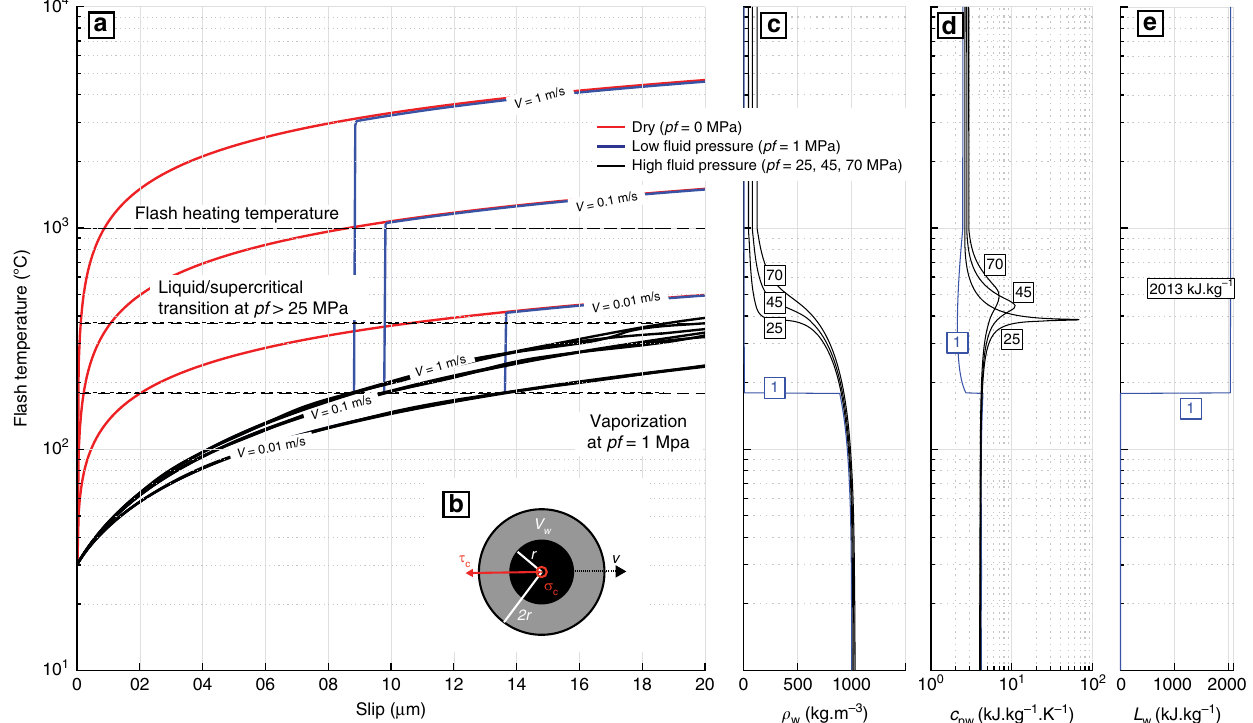
Fig. 4 Flash temperature calculation. Red curves correspond to dry conditions, blue to low fl uid pressure (1 MPa) and black to high fl uid pressures (25, 45 and 70 MPa). a Flash temperature reached at the asperity contacts versus slip (e.g. Methods). b Schematic top view of the considered contact geometry, in black we see the asperity contact of radius r = 20 μ m stressed at a normal stress σ c and at a shear stress τ c . The asperity is surrounded by a volume of water V w , which buffers temperature. c Temperature versus water density 25 for the different fl uid pressures in MPa. d Temperature versus water speci fi c heat 25 . e Temperature versus water ’ s latent heat 25 . Note that the latent heat ( L w ) decreases with rising pressure until it vanishes at the critical point (~22 MPa and ~373